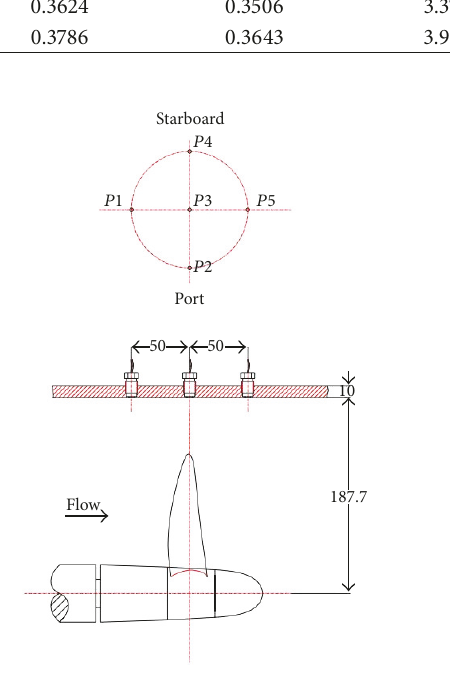
Figure 5: Arrangement of sensors for measuring pressure fluctua-